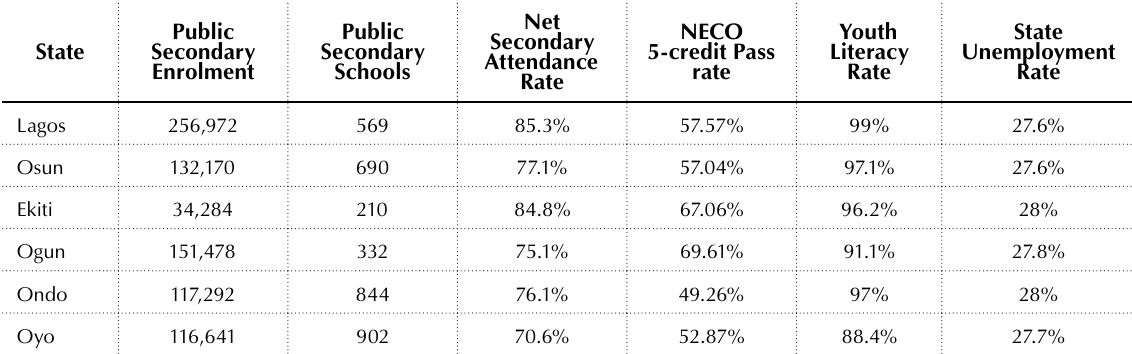
Table 1. Selected education metrics – South-West